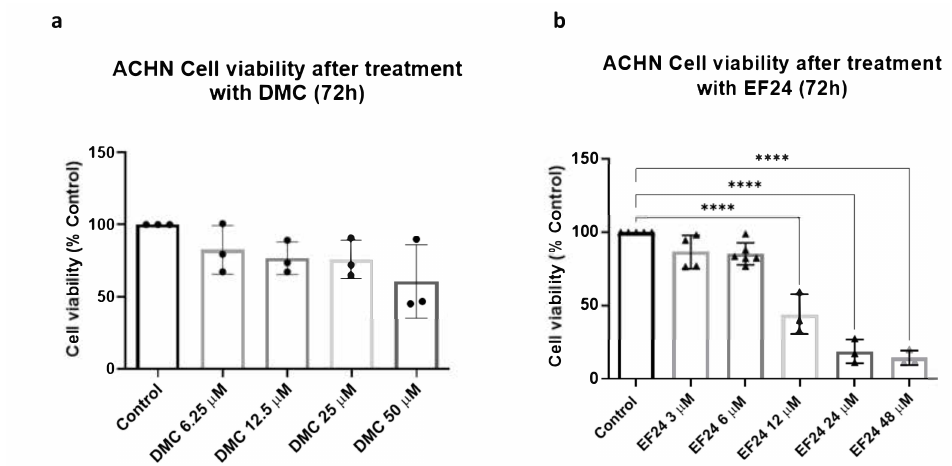
Figure 1. ACHN cell viability measured using MTT assays after 72 h of treatment using either DMC or EF24. ( a ) Cell viability decreases with increasing concentrations of DMC over a 72 h period. Results shown are an average of 3 independent experiments. ( b ) Treatment with increasing concentrations of EF24 reduces ACHN cell viability Cell viability decreases to 43.62% at a 12 µ M of EF24 and 18.69% at 24 µ M. Results shown are an average of 4 independent experiments. **** p ≤